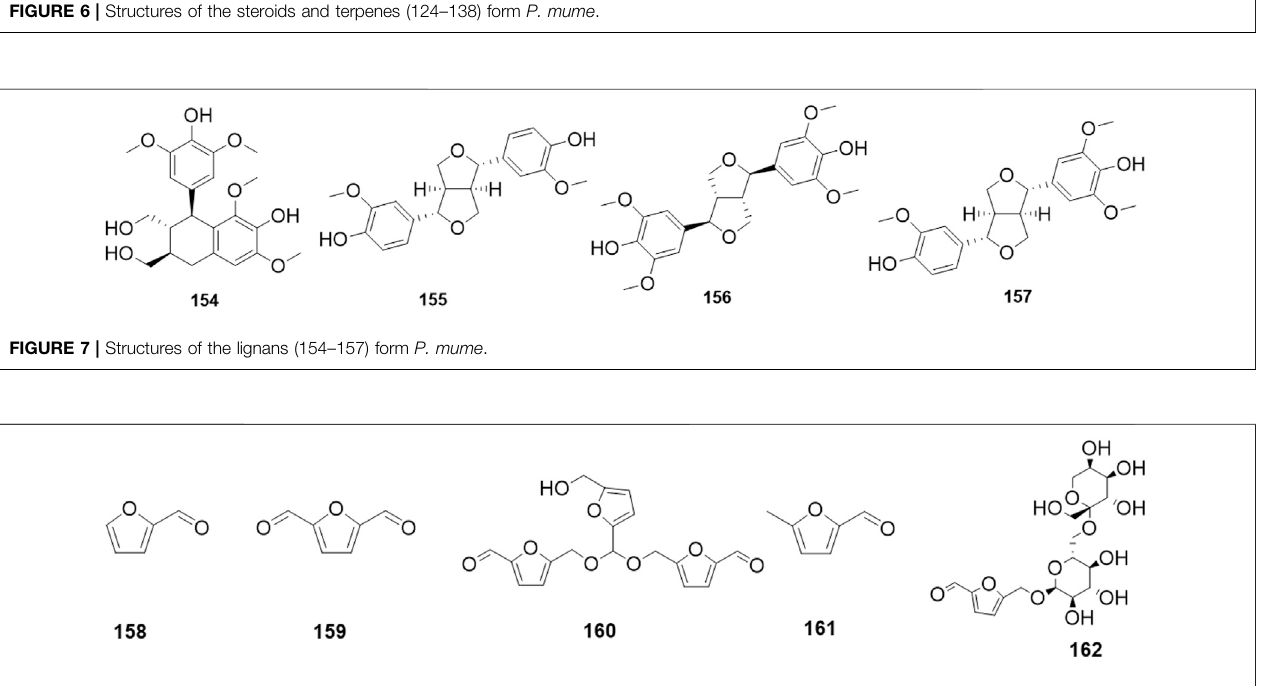
FIGURE 8 | Structures of the furfurals (158 – 162) form P. mume